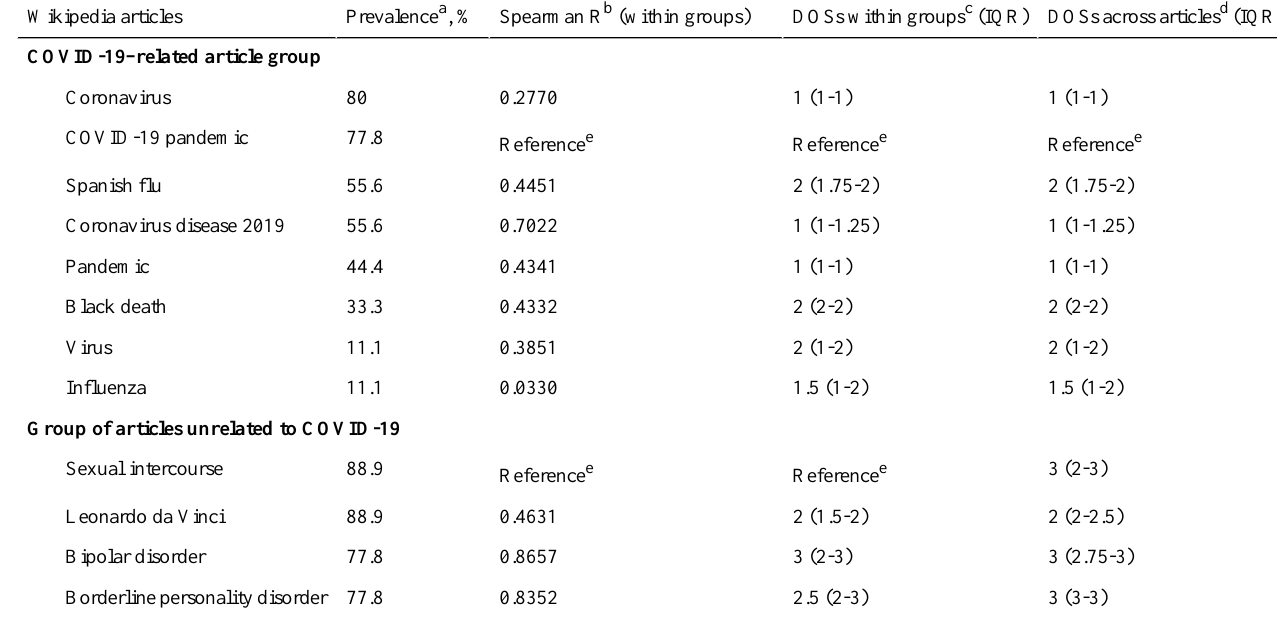
Table 1. Degrees of separation (DOSs) between investigated articles and reference articles within and across article clusters for the 2016-2019 and 2020